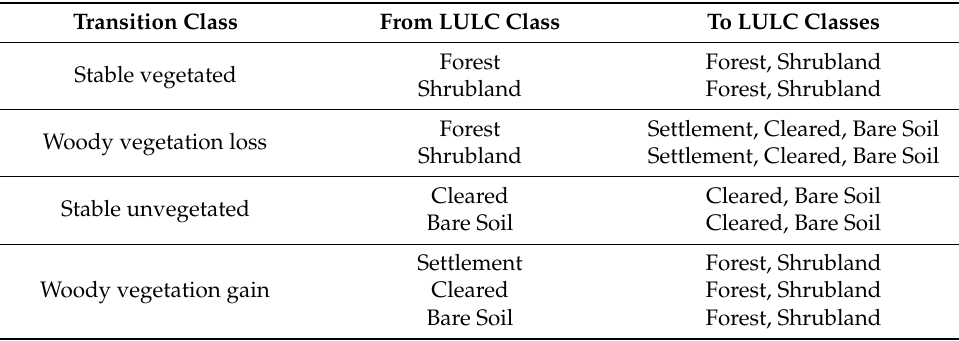
Table 3. Established transition classes used for the description of areas that experienced changes of vegetation cover and as a basis for the binomial logistic regression